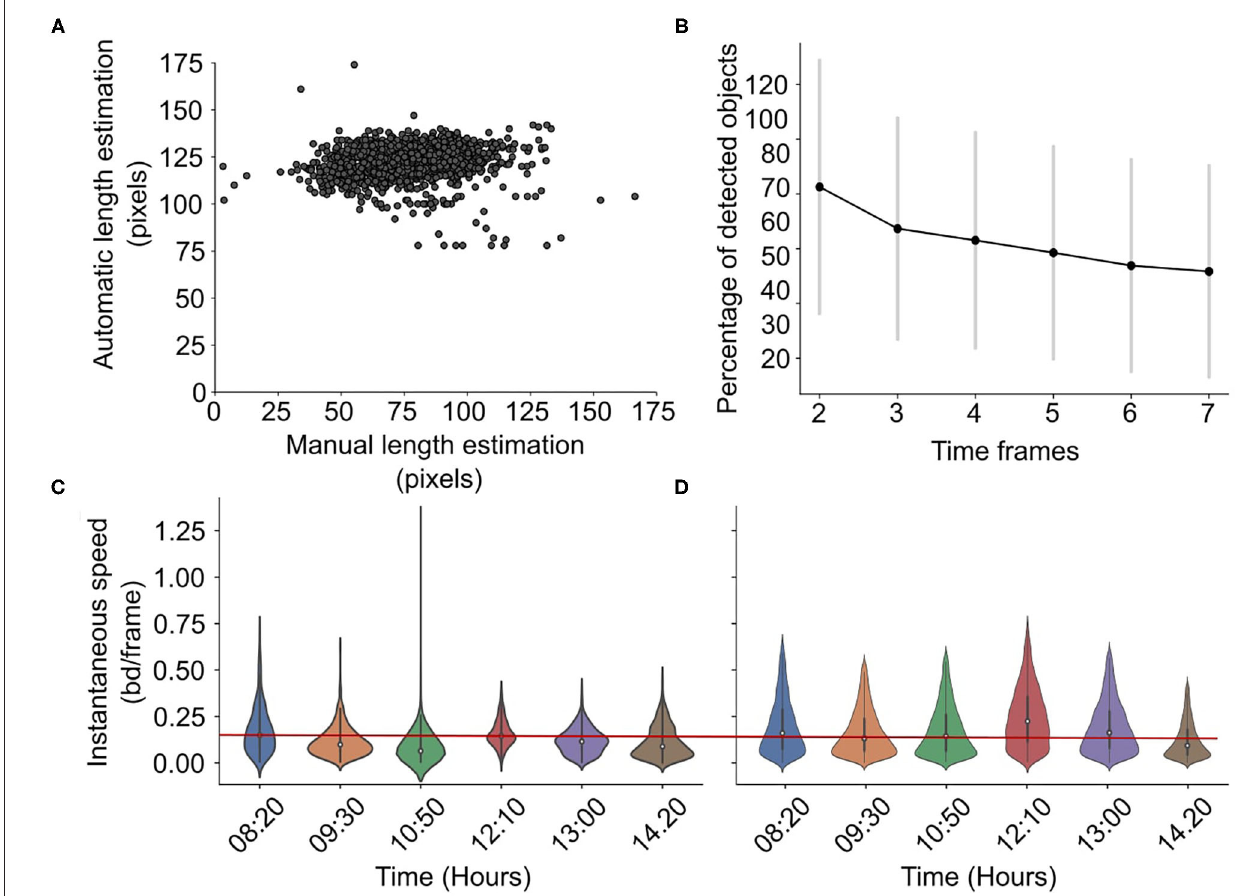
FIGURE 5 | Accuracy in RAS. Scatterplot showing the manual vs. automatic length estimation (A) and the percentage of detected objects for different time frames (B) . Violin plots showing the manual (C) vs. automatically (D) estimated speed distribution for different hours in a day in RAS, with a reference red line for easier comparison. The speed is normalized, i.e., it is expressed in body-lengths per